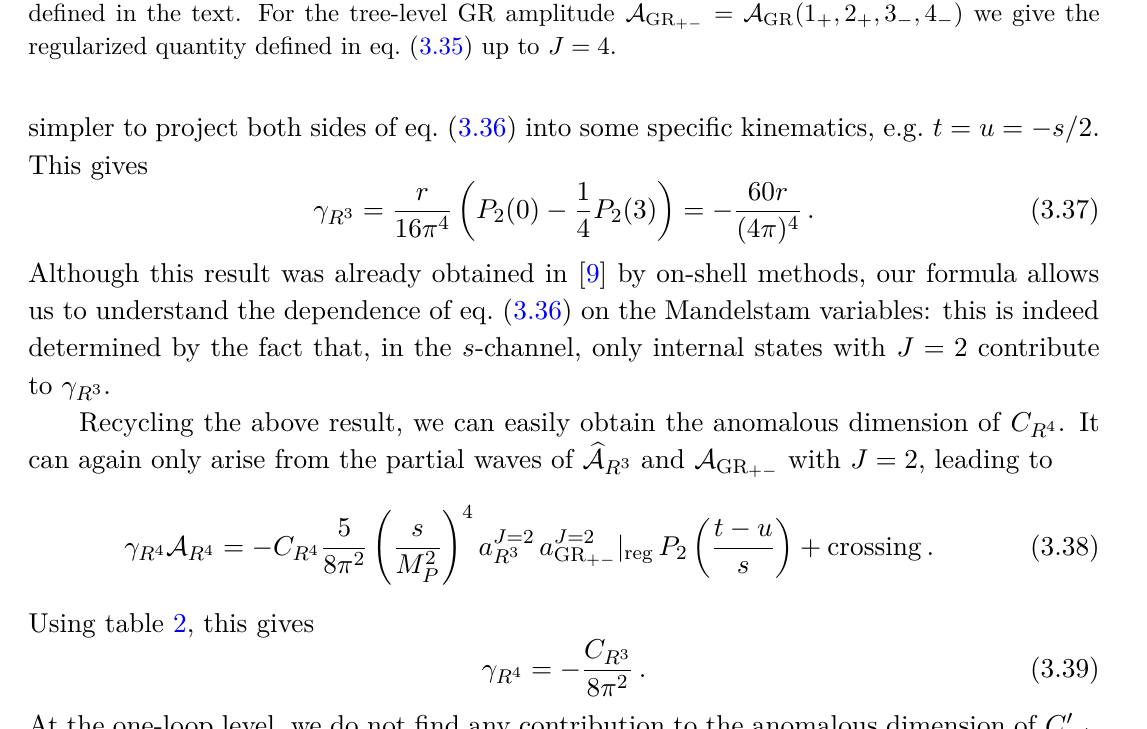
= A GR (1 + , 2 + , 3 − , 4 − ) we give the + −